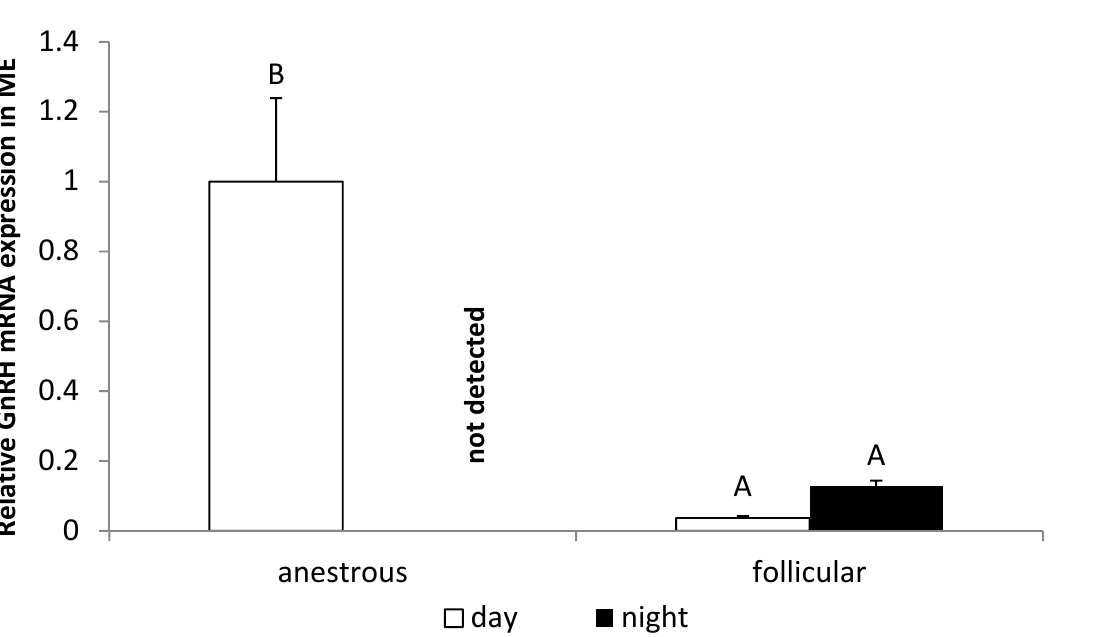
Figure 3. The day/night changes in the GnRH peptide ( A ) and mRNA ( B ) expression in the preop- tic area (POA) of the anestrous and follicular phase ewes. Gene expression data were normalised to the average relative level of GnRH gene expression measured in the anestrous animals from the day experiment, which was set to 1.0. All data are presented as the mean (±S.E.M.). Different capi- tal letters indicate significant ( p < 0.05) differences according to a two-way ANOVA followed by NIR Fisher’s post-hoc test.